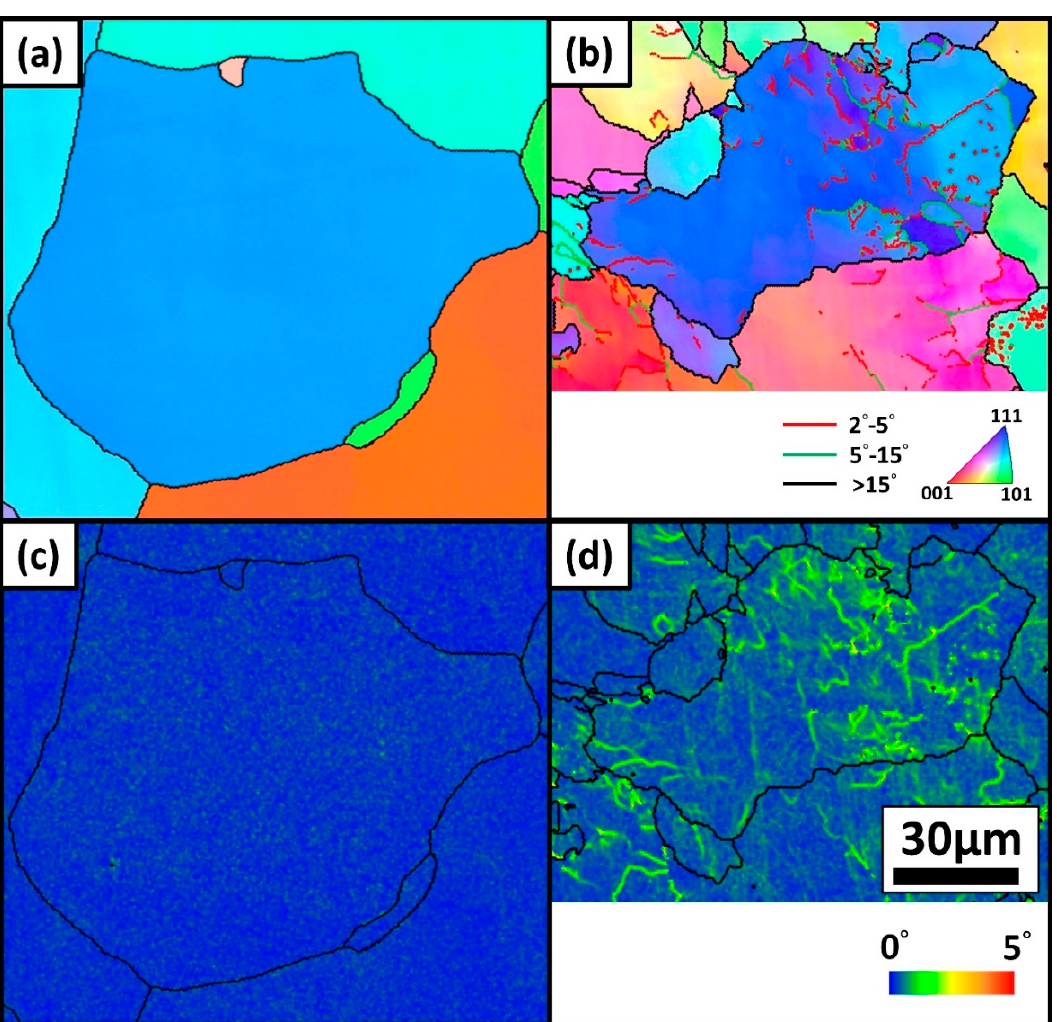
Figure 3. Inverse pole figures (IPF) of ( a ) allotriomorphic ferrite and ( b ) massive ferrite in Steel A. kernel average misorientation (KAM) analysis of ( c ) allotriomorphic ferrite, and ( d ) massive ferrite in Steel A.